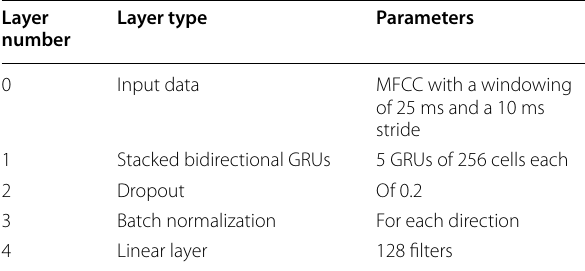
Table 5 Architecture used for siamese and prototypical networks